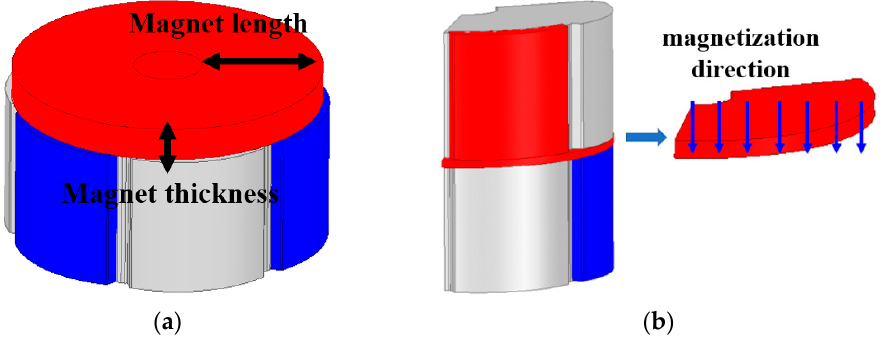
Figure 9. Center magnet intersect consequent pole: ( a ) center magnet parameters, ( b ) center magnet magnetization direction.